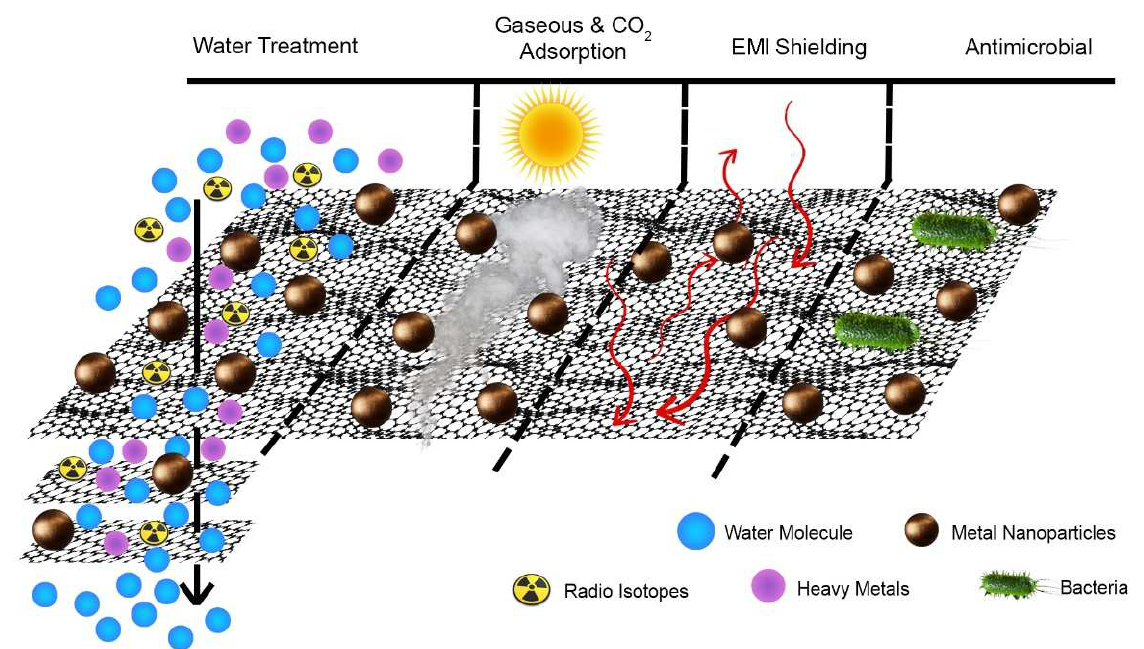
Figure 1. Schematic illustration of graphene oxide hybrids for environmental applications in water purification, gaseous CO 2 adsorption, electromagnetic shielding, and antimicrobial elimination.